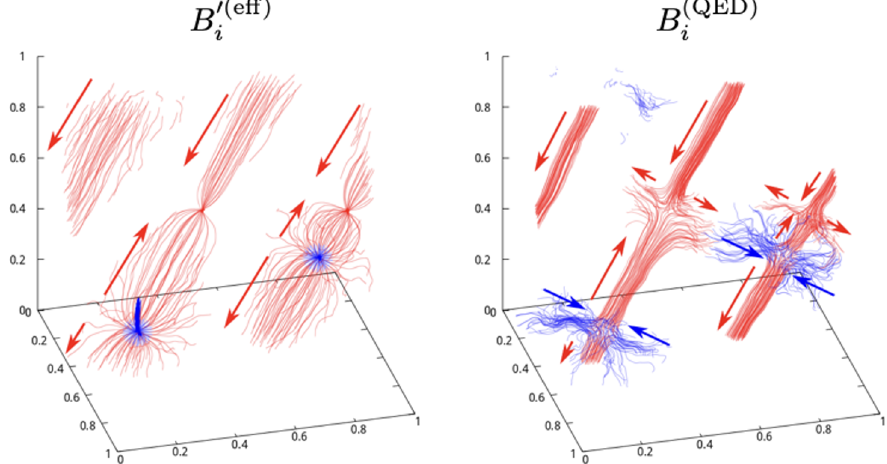
( left ) and B (QED) ( right ) at Figure 8 . The stream line constructed by the magnetic field B 0 (eff) i i ηv 1 = 79 . 0 . We focus on the magnetic flux arising from two lower monopoles on the two diagonal cosmic strings in figure 7. The axis labels indicate the spatial coordinate normalised by the box size. The stream lines start from a certain distance from the monopole points of the monopoles. The red ones are the stream lines flowing out of the monopole region, while the blue ones are those for the “negative” length parameter. (See the appendix C for details of the stream line.) The arrows with a corresponding color indicate the direction of the flux. In the left panel, the blue lines show that the magnetic flux are ending at the monopole points, while the red ones show that the magnetic flux flows along the cosmic strings and reach the left monopoles. The right panel shows that the induced flowing out of the monopole regions (red) follows the cosmic strings, while it actually goes B (QED) i outside of the monopole region